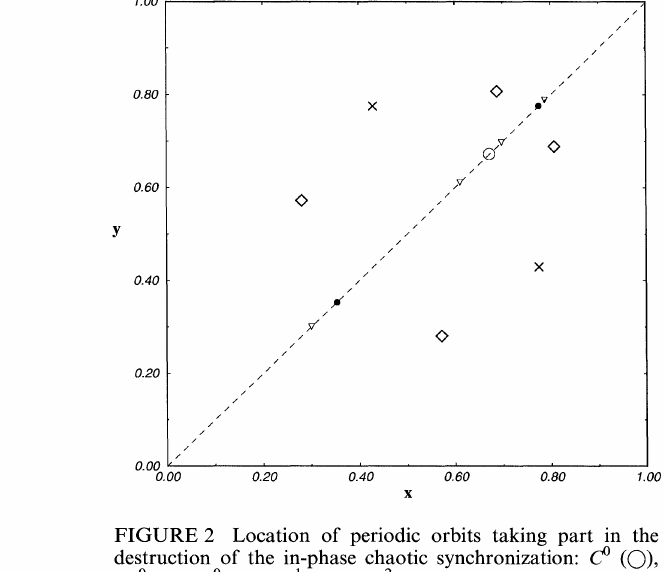
FIGURE 2 Location of periodic orbits taking part in the destruction of the in-phase chaotic synchronization: C o (C)), 2C (.), 4C (7), 2C ), 4c